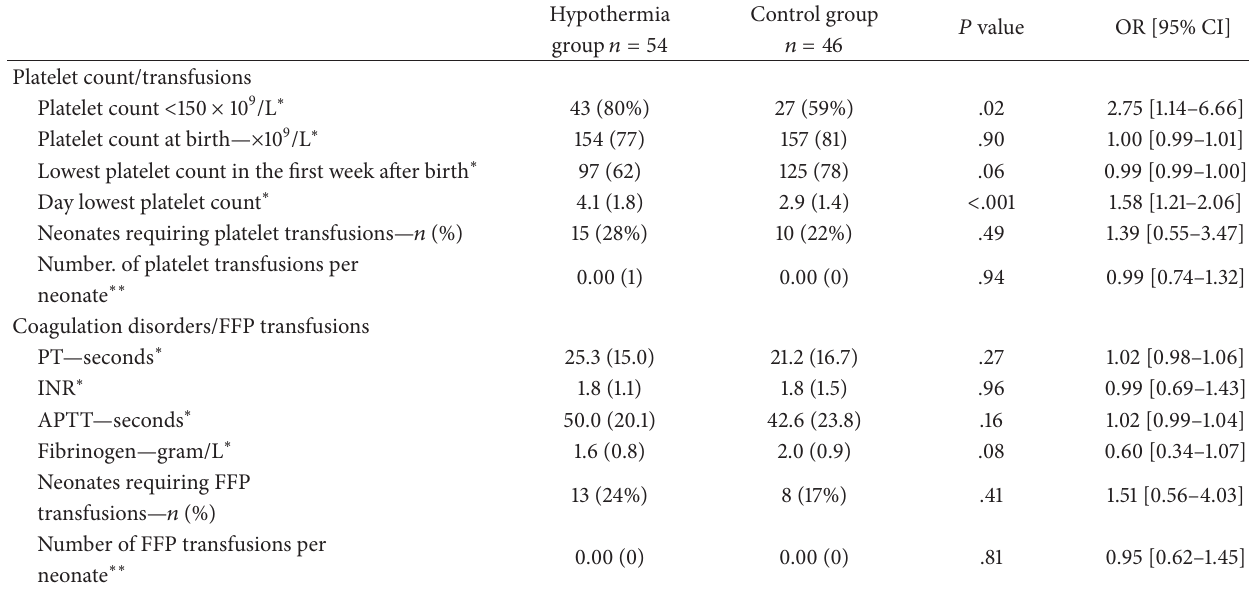
Table 2: Hematologic results of the study population.